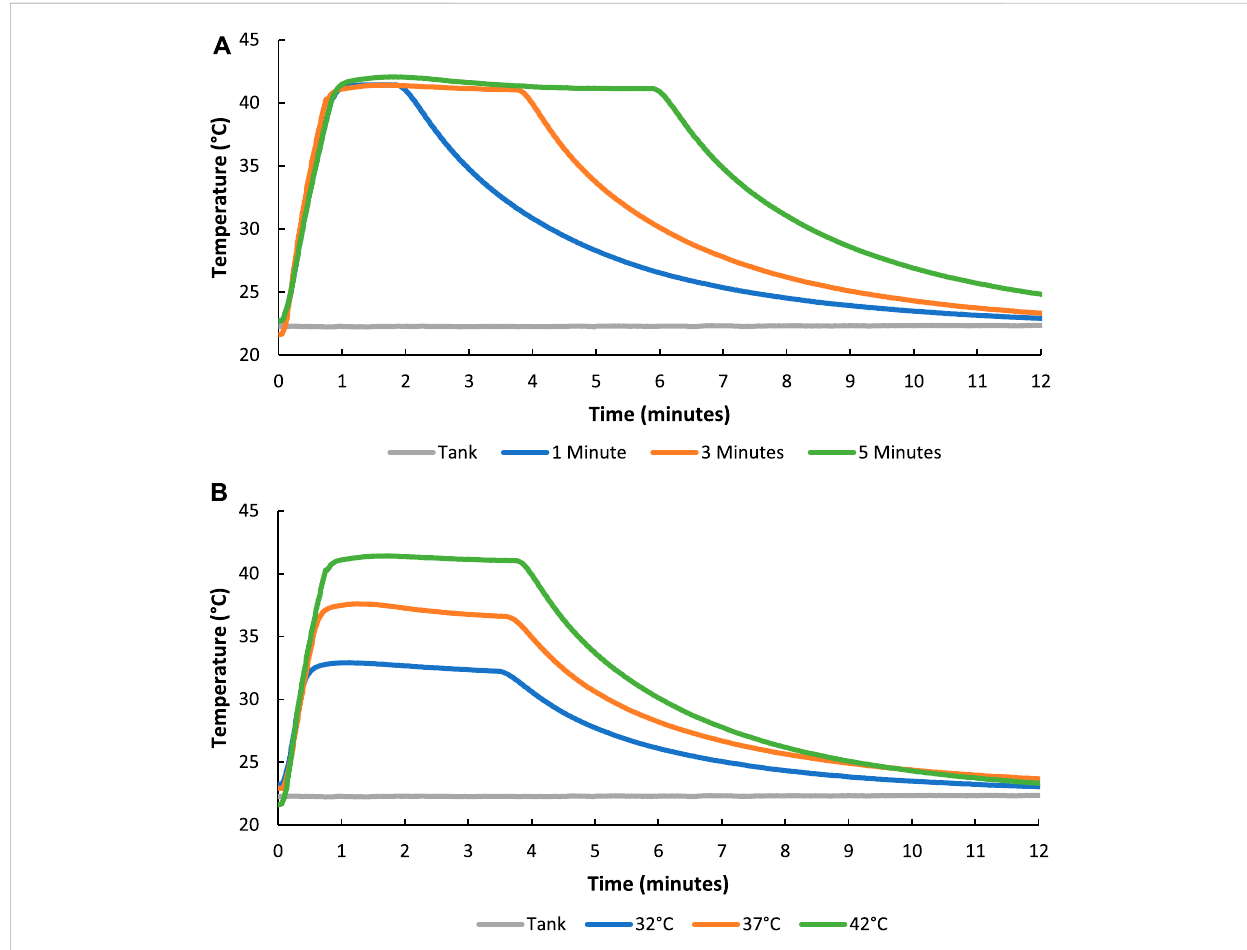
FIGURE 8 Graphs showing how the duration (1, 3, and 5 min of 42 ° C FUS maintenance) (A) and magnitude (32 ° C, 37 ° C, and 42 ° C) (B) of FUS heating treatment of the composite hydrogels could be tightly